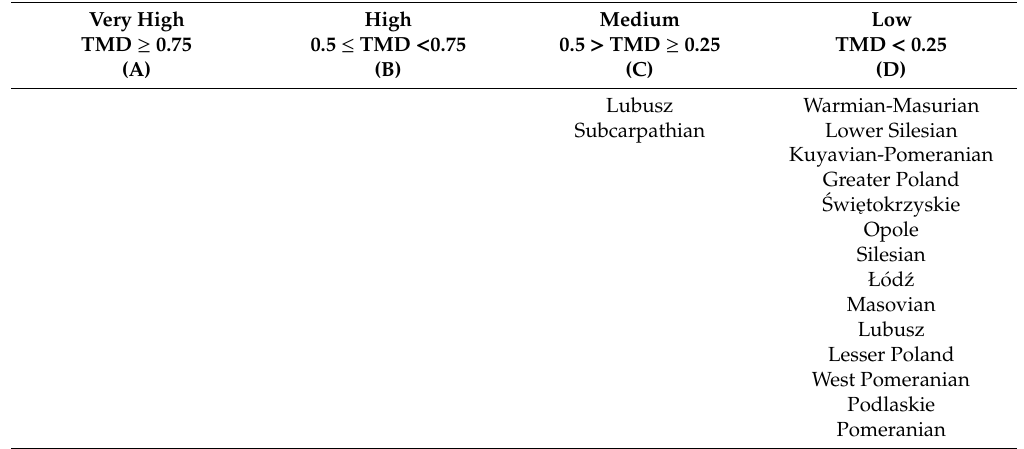
Table 4. Comparison of the level of sustainable development of Polish provinces according to the taxonomic measure in the area of environmental order (2016). The Level of Sustainable Development in the Area of Environmental Order: Very High TMD ≥